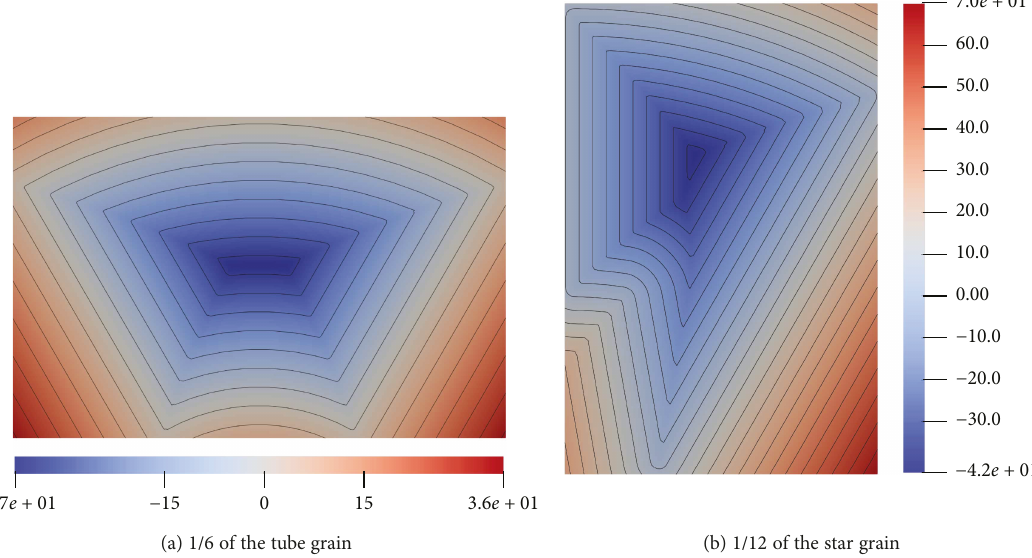
Figure 11: Contour of SDF of sample grains.